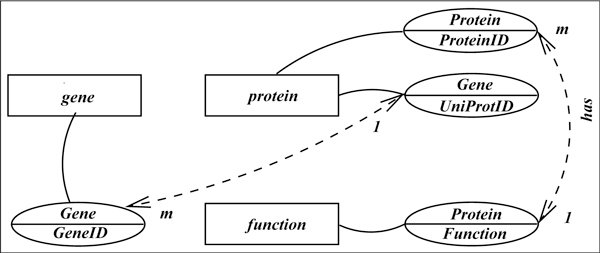
Logical query graph.